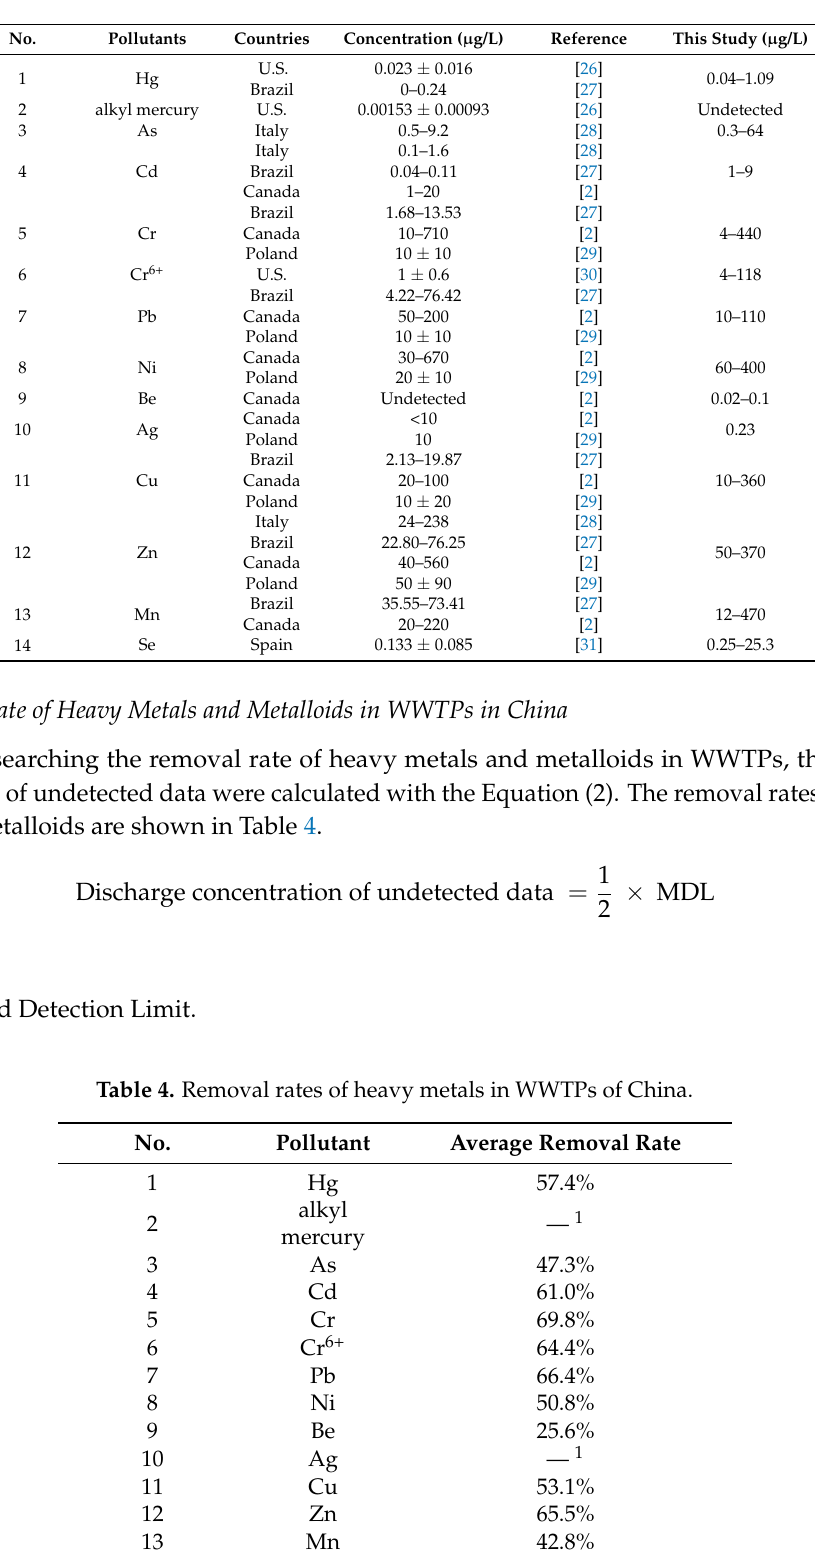
Table 3. Comparison of discharge concentrations of 14 heavy metals and metalloids in WWTPs of China and other countries.